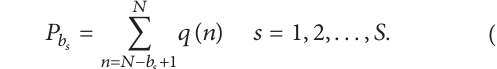
Figure 3: The blocking probability of users in two load distribution scenarios versus the arrival rate of total